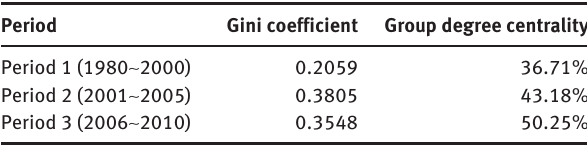
Table 3: Gini coefficient and group degree centrality results across patent